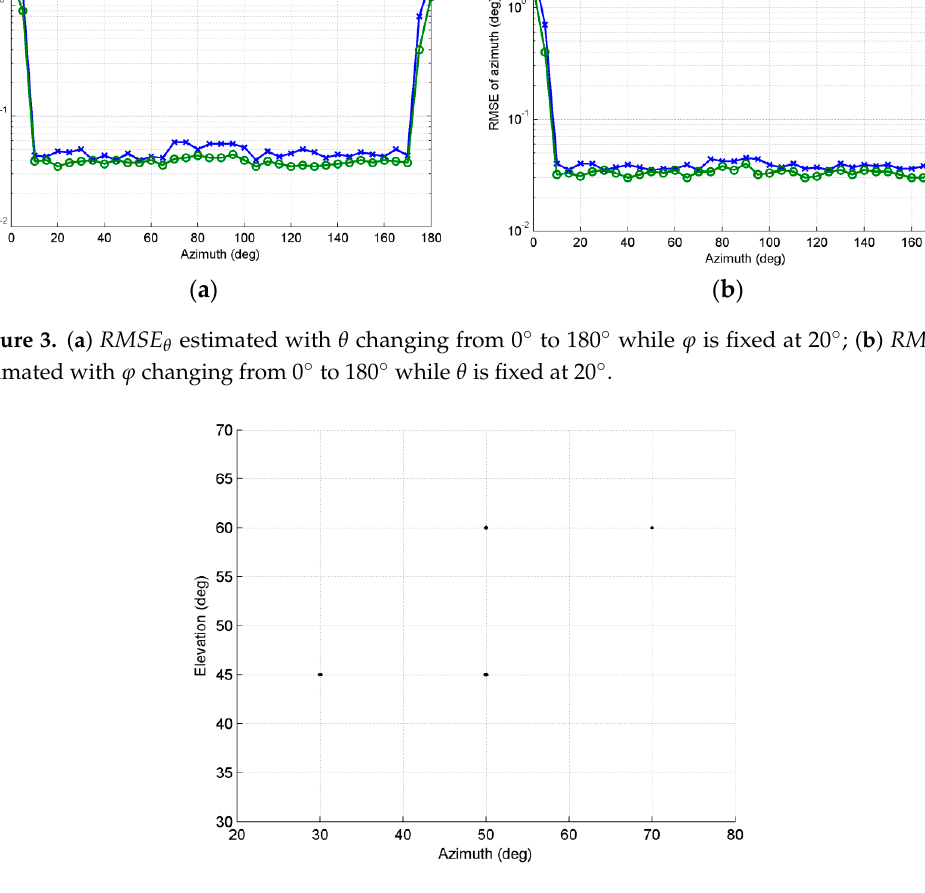
Figure 4. Estimated results for 2D ID sources with different angular power density functions.